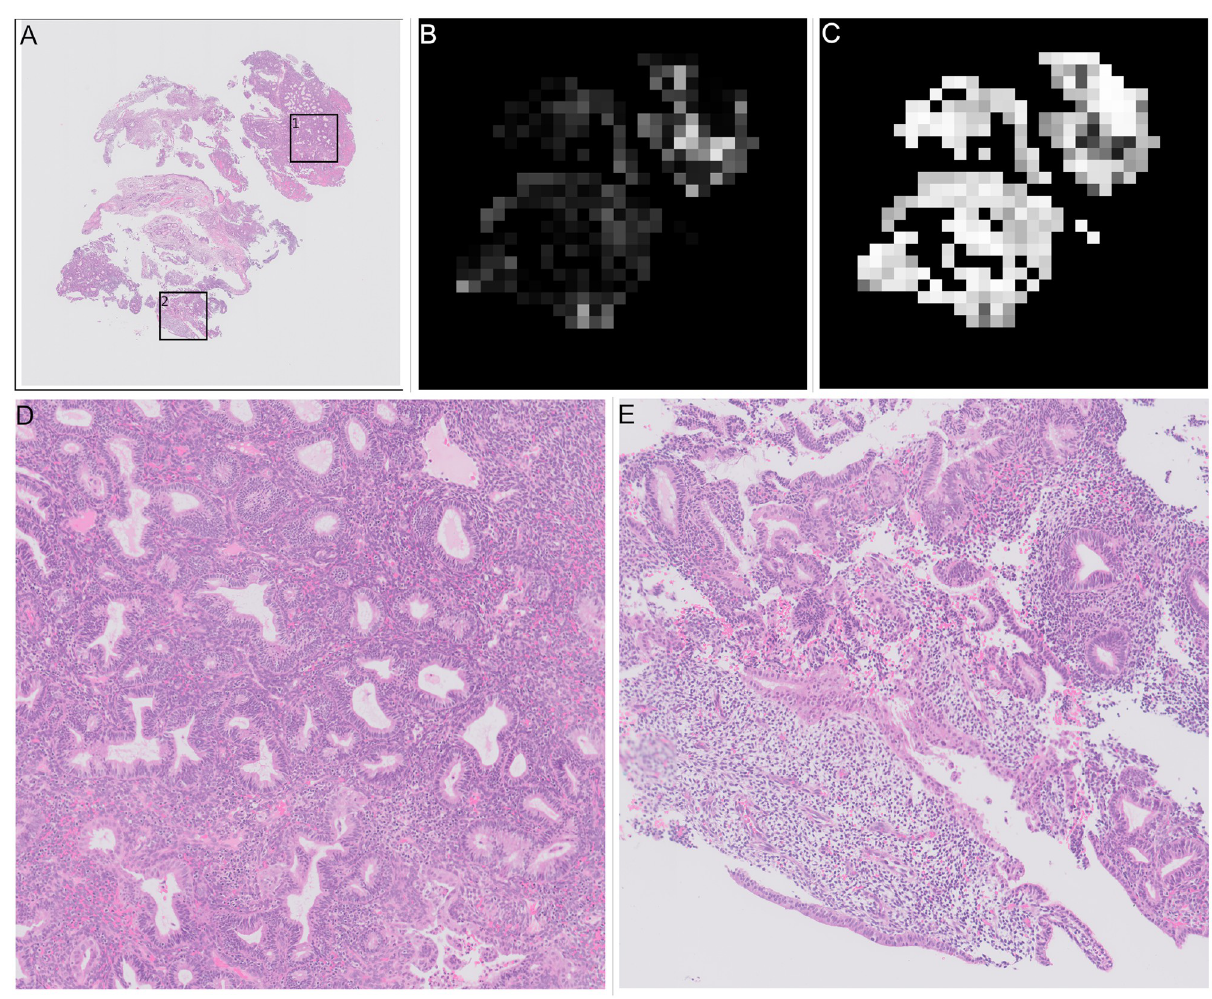
Fig 18. Example of a slide where the output of the patch classifier is wrong. (A) Thumbnail showing “malignant” slide where patch classification is incorrect. Square 1 shows area in Fig 18d. Square 2 shows area in Fig 18e. (B) Results of “malignant” heatmap patch classification showing probability of “malignant”, white = 1, black = 0. (C) Results of “other or benign” heatmap patch classification showing probability of “other or benign”, white = 1, black = 0. (D) Zoomed in on area with highest probability of being “malignant” (square 1). (E) Zoomed in on area with highest probability of being “other or benign” (square